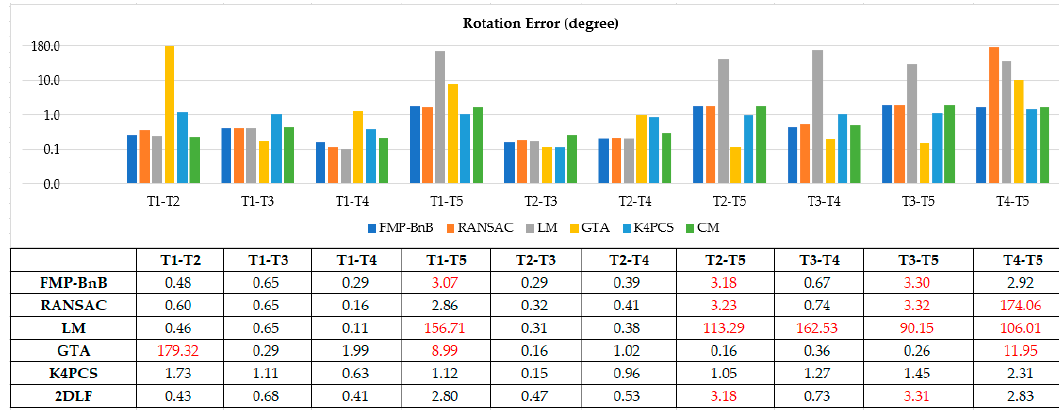
Figure 8. Rotation error of point cloud pairs from dataset SR (the failed pairs are colored in red).